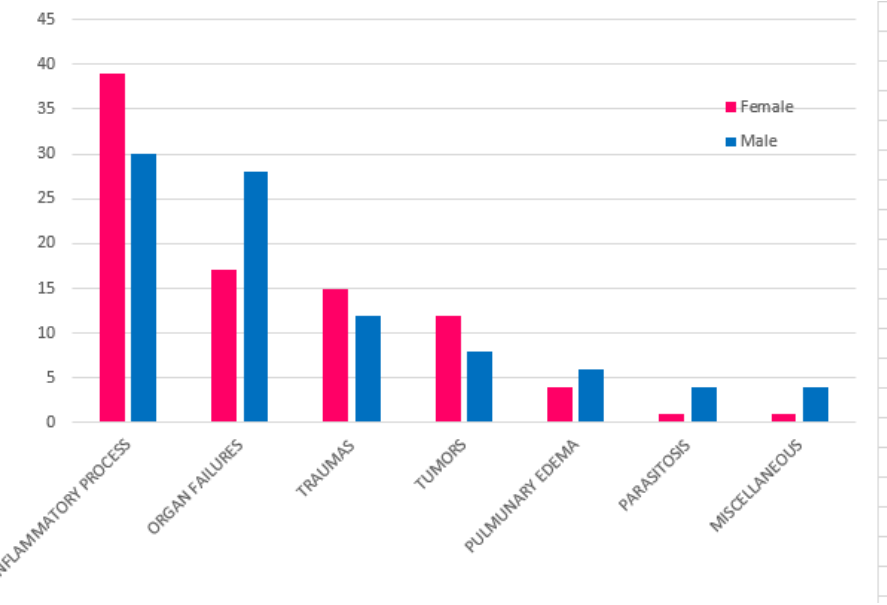
Figure 3. Relation between cause of death and sex of colony cats included in the study .